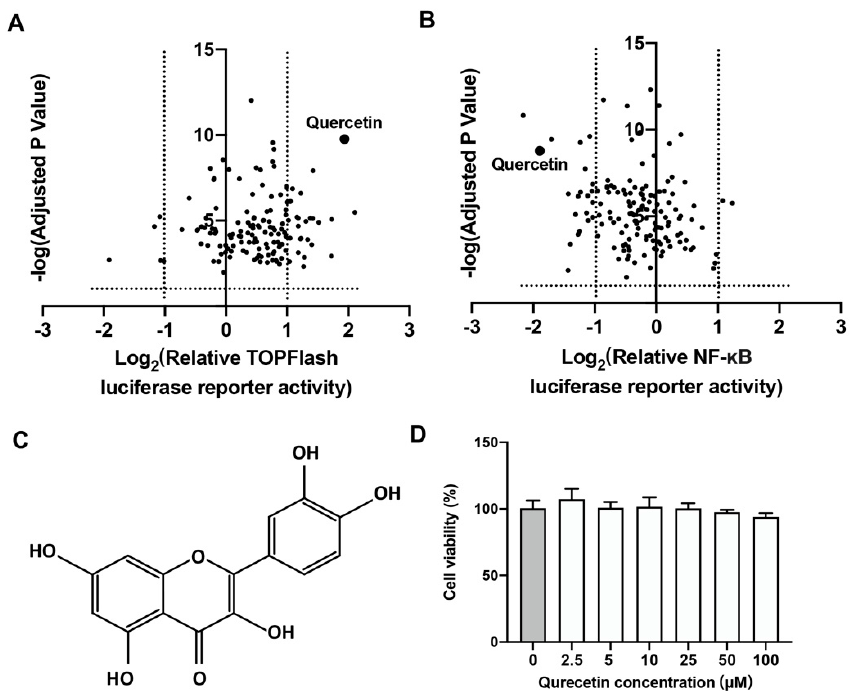
Figure 1. Screening of small molecules repressing the luciferase activity of TOPFlash and NF- κ B response element system A&B. Volcano plot analysis of TOPFlash ( A ) and NF- κ B response element ( B ) luciferase activities upon small molecule library treatment. Quercetin was highlighted. Molecular conformation of quercetin ( C ). Cytotoxicity assay of mouse BMSCs after treated with quercetin at different concentrations for 3 days ( n = 6) ( D ).